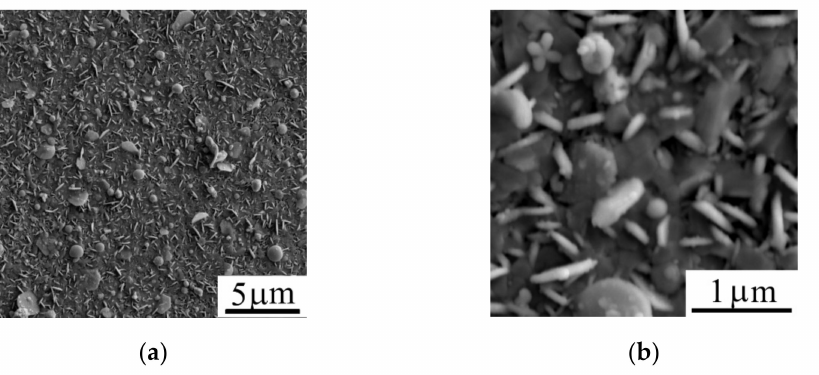
Figure 8. ( a , b ) SEM images (two magnifications) of the MoS x /WSe 2 /C(B)/Al 2 O 3 sample.